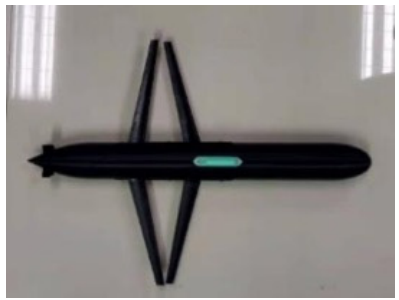
Figure 13. The S-AUG model.